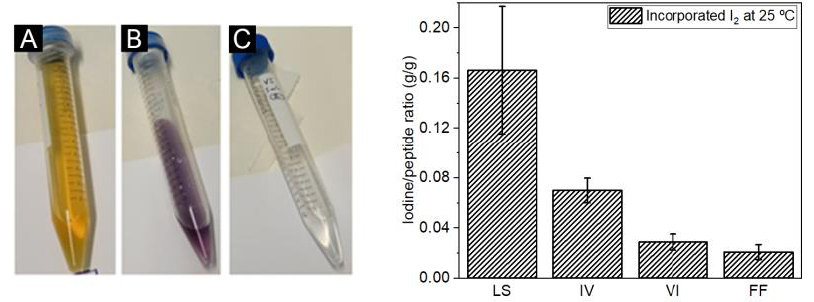
Figure 2. Left: peptide solution during iodine titration showing the solution after the addition of ( A ) potassium iodide, ( B ) soluble starch solution and ( C ) at the end of titration. Right: iodine content (in g of iodine/gram peptide) after I 2 incubation for 24 h at 25 °C.